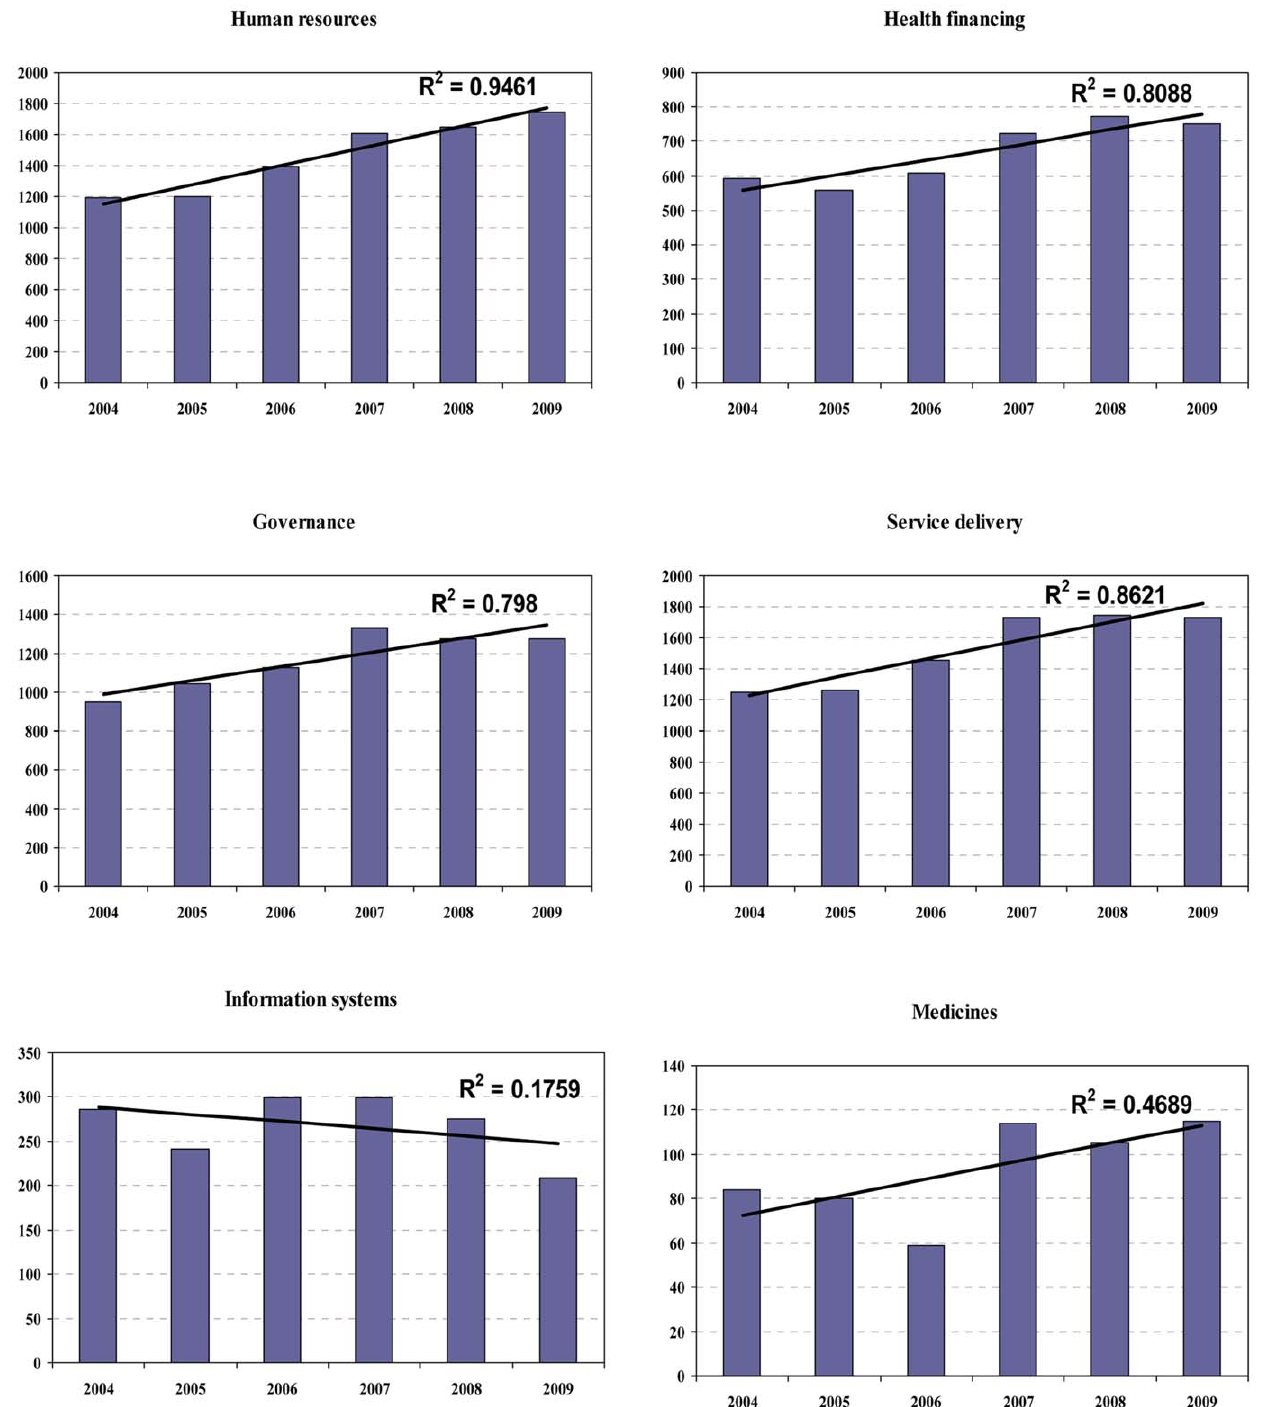
Figure 3. Trends in HPSR publications relevant to LMICs over time by topic area (2003–2009).